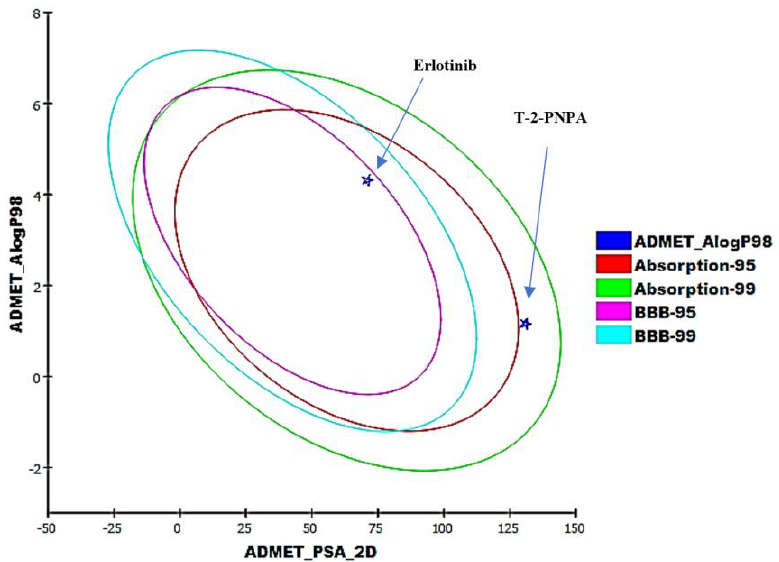
Figure 14 . TED and ESP maps of T-2-PNPA at the 6-311G++(d,p) basis set.